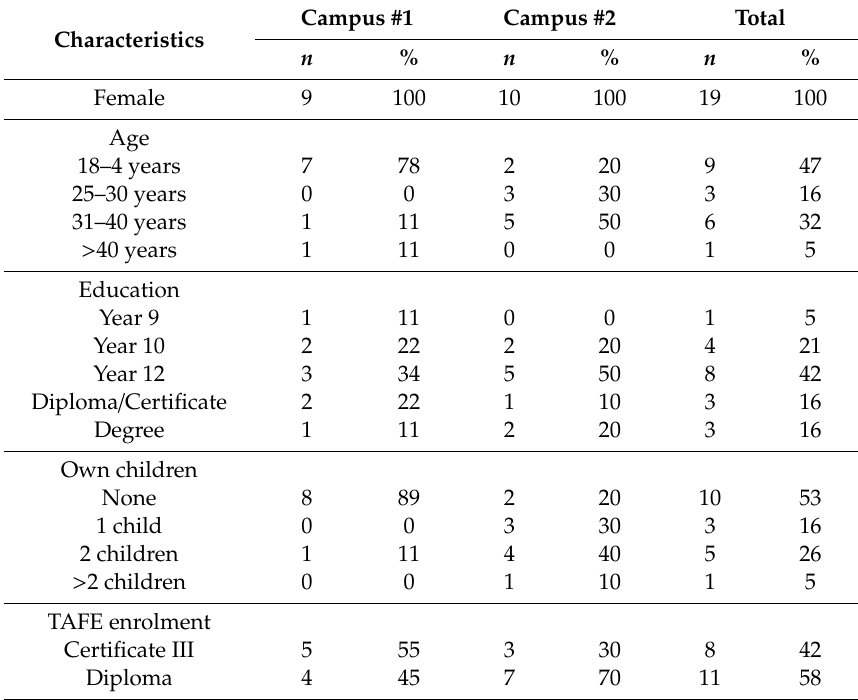
Table 1. Demographic characteristics of focus group